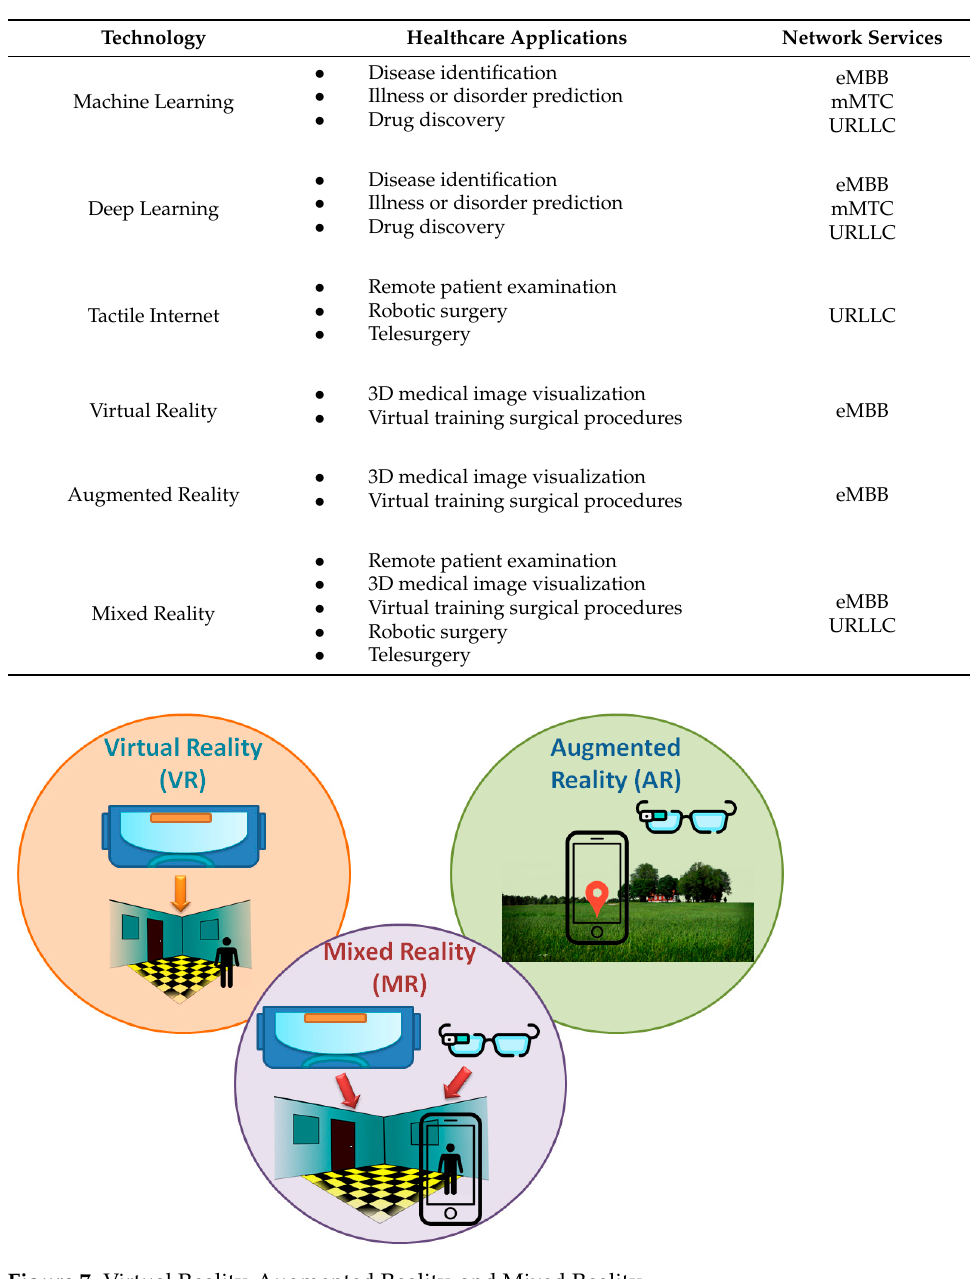
Figure 7. Virtual Reality, Augmented Reality, and Mixed Reality.